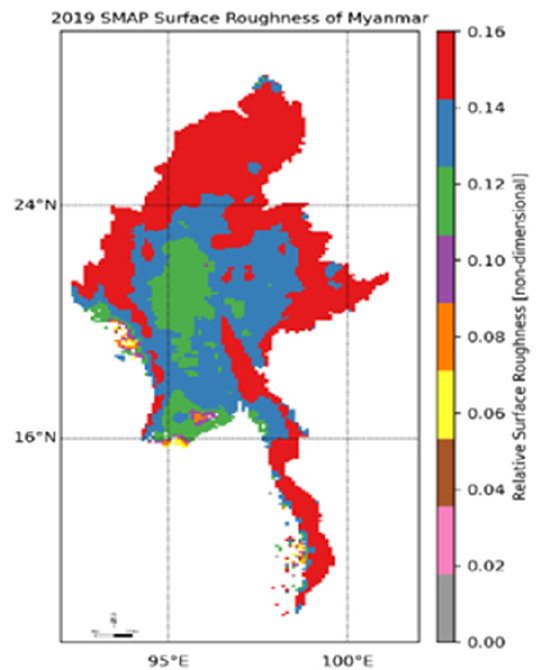
Figure 1. Surface roughness map prepared from the SMAP L3 Passive Radiometer. Surface roughness, which is the h parameter, closely influences soil moisture availabil- ity. SMAP radiometer sensors operate in the microwave L-band, and the effect of surface roughness is a key parameter compared to vegetation. In theory, surface roughness is less sensitive than vegetation biomass in microwave emission and backscatter to soil moisture variations. The vegetation canopy and seasonal weather conditions are also significant factors in soil moisture